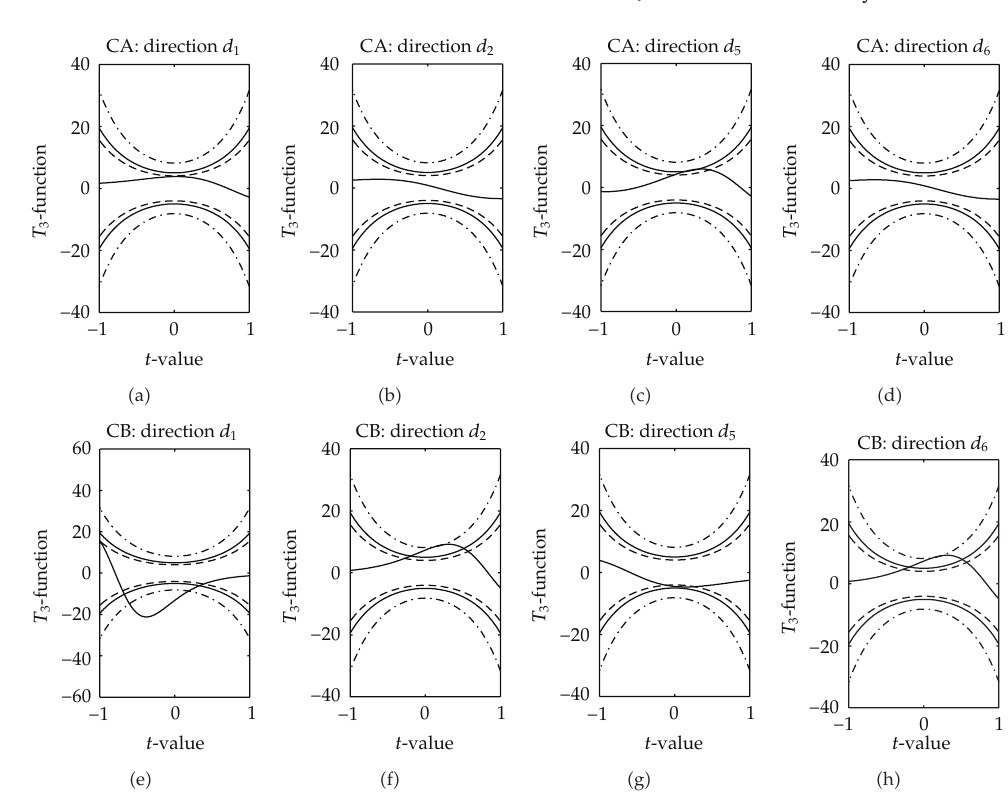
Figure 2: ST 3 -Plots for the two centerized subsets of data in Groups A and B from the VDP data on four selected projection directions. d 1 , d 2 , d 5 , and d 6 have the same meaning as that for Tables 1 and 2, respectively. For each plot, the region between the two dashdotted curves stands for the 99% acceptance region, the region between the two real-line curves for the 95% acceptance region, and the region between the two dashed curves for the 90% acceptance